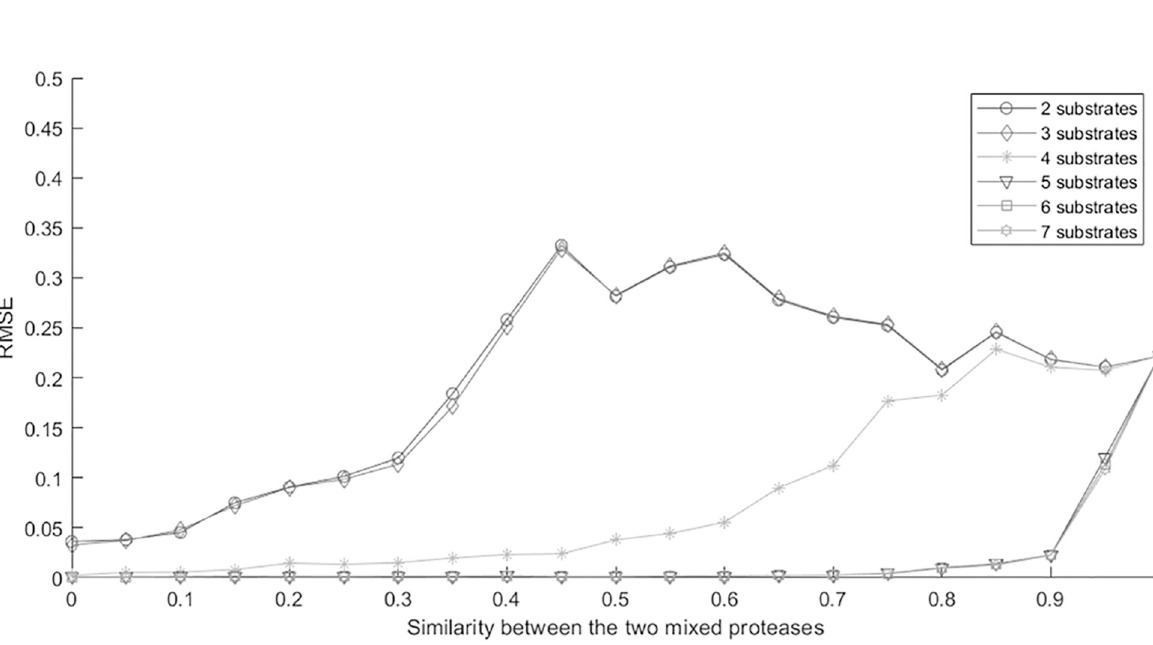
Fig 2. RMSE reflected the level of difficulties in deconvolution of the simulated protease mixtures. The x-axis represents the similarity between the two proteases in the mixture. A higher similarity between proteases led to a higher correlation between their cleavage dynamics, and thus higher difficulty in deconvolution. The y-axis was the RMSE of the estimated mixing coefficients. For each substrates-proteases setting, repetition P = 200 was used to calculate the corresponding reported RMSE. Each curve represented a simulation series with a different number of substrates. A smaller number of substrates corresponded to more difficult situations for deconvolution